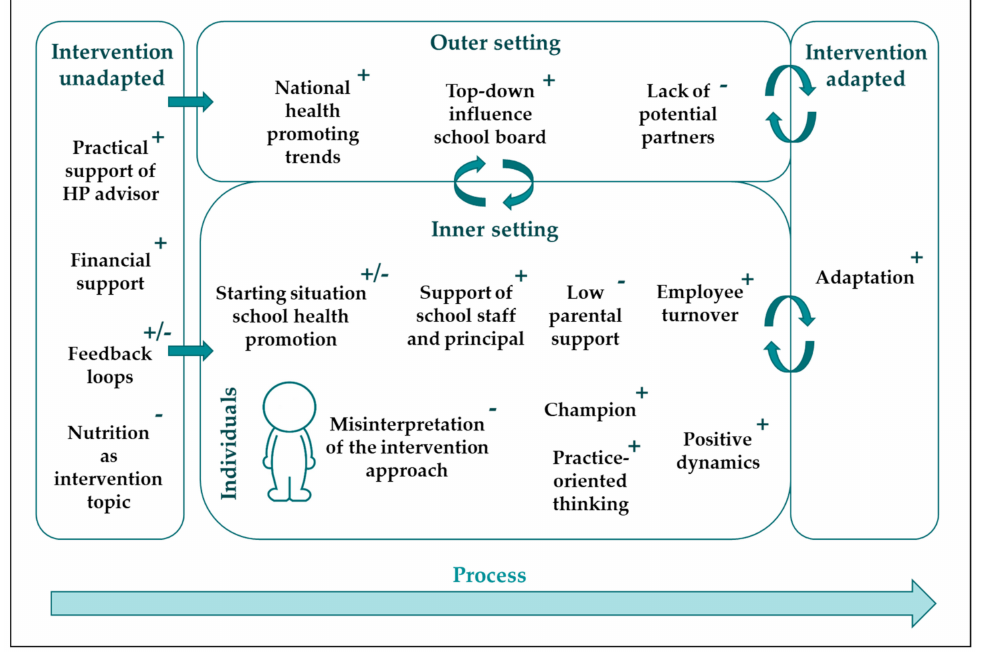
Figure 4. Facilitating ( + ) and hindering (-) factors in the implementation of PA and healthy nutrition-promoting activities in the schools per domain of the Consolidated Framework for Implementation Research (CFIR) (adapted from